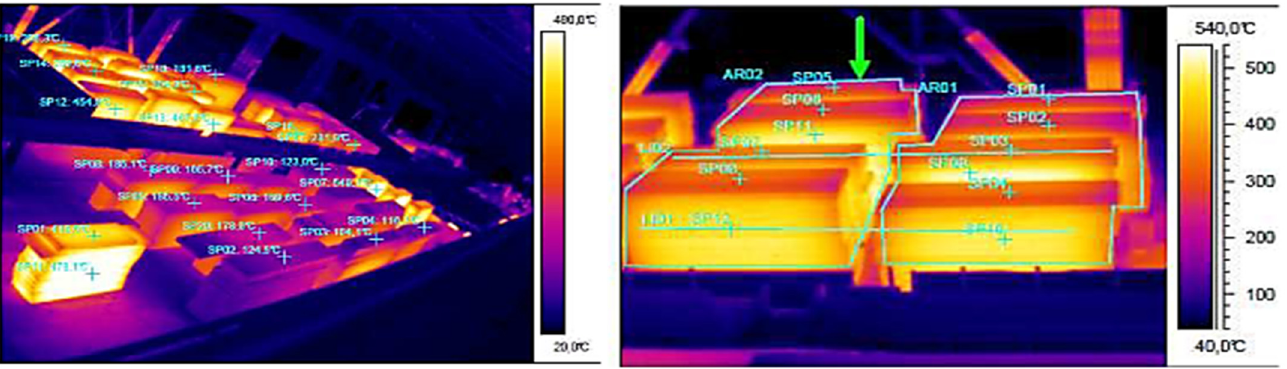
Table 5. Ingot heating zones in walking beam furnace.